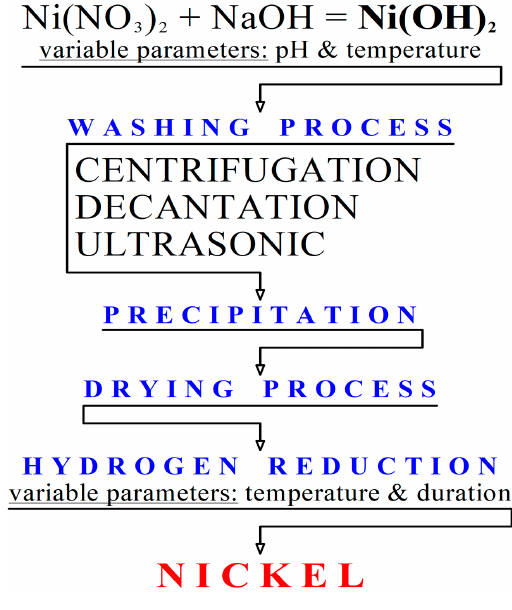
Figure 1. Scheme for the production of the nickel nanoparticles. Table 1. Synthesis conditions of the nickel hydroxide and nickel